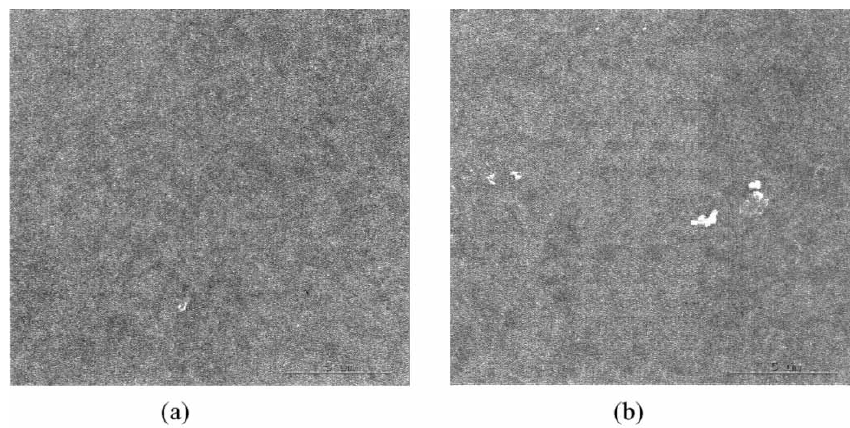
FIGURE 13 SEM results of (a) slowly cooled and (b) quenched n -Si sample from 400 (cid:1) C with scale of 5